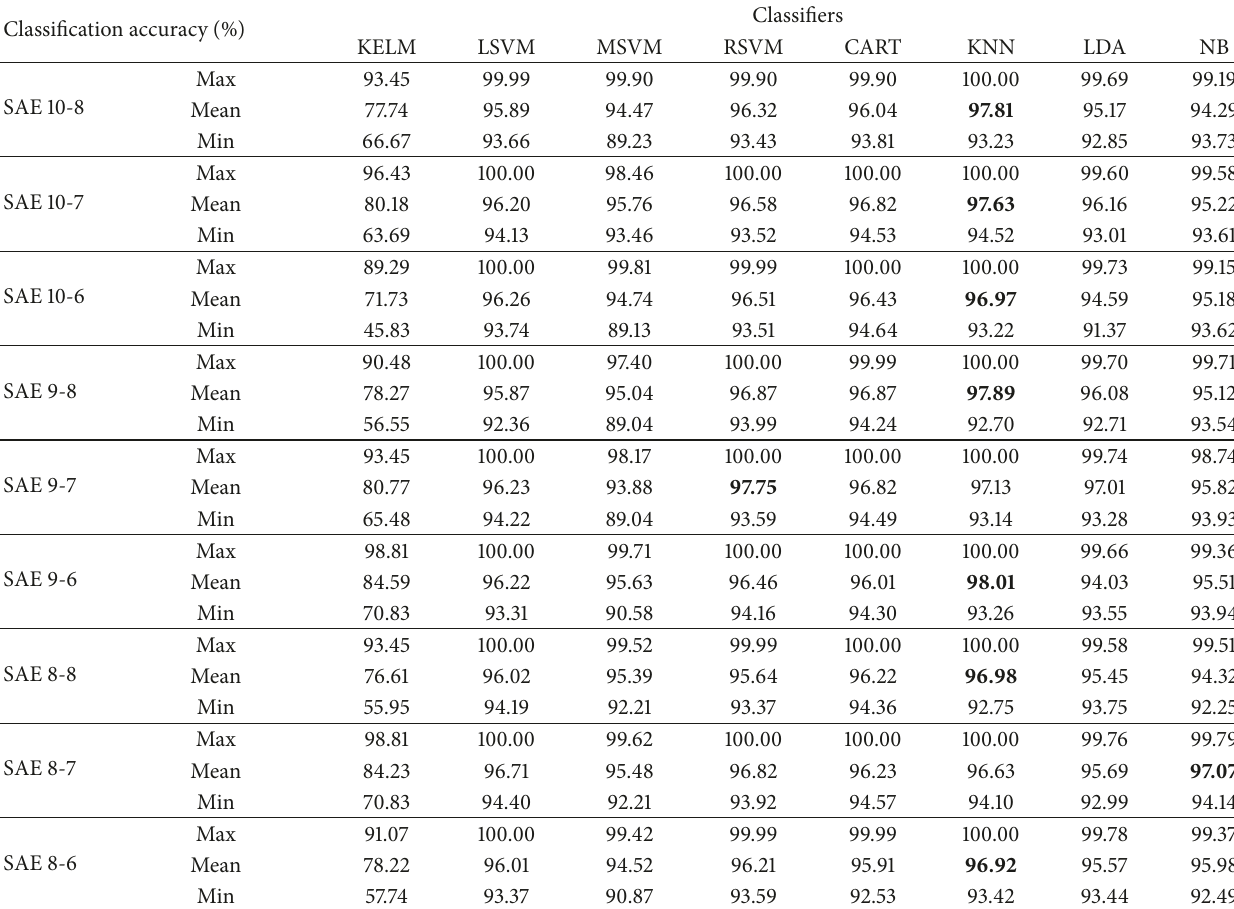
Table 4: Results of comparative classifiers with SAE on Oxford